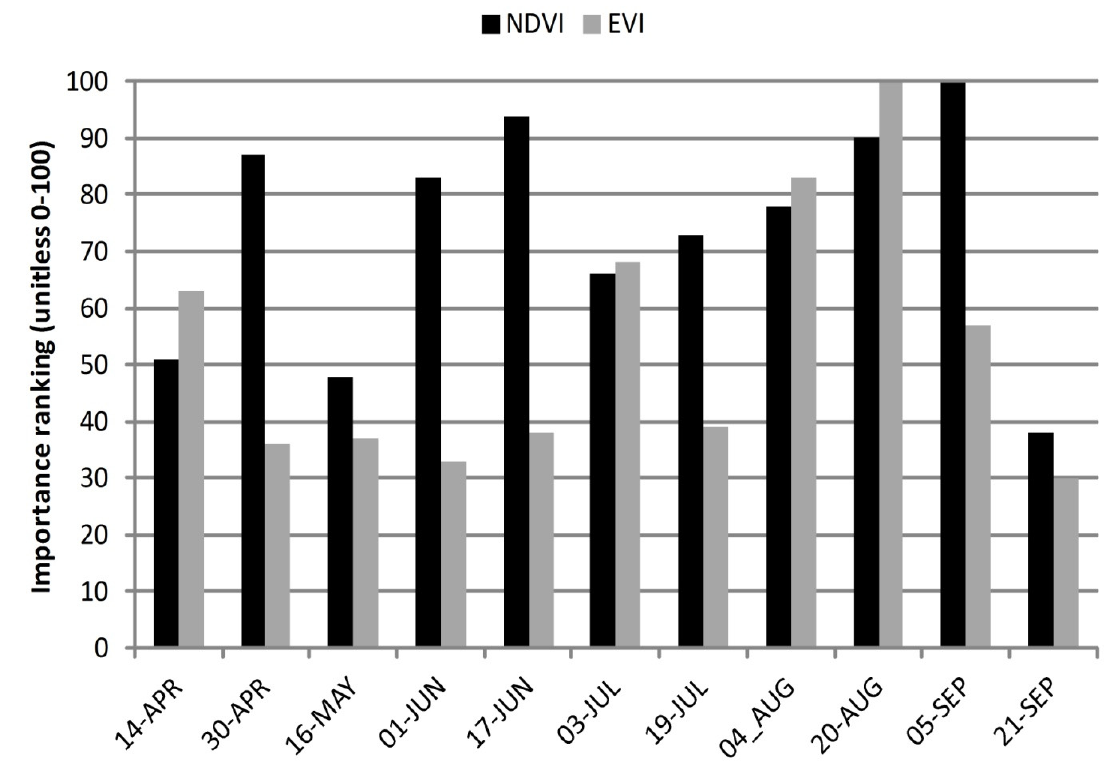
Figure 9. Variable importance for the best case classification of the raw data series (RD).